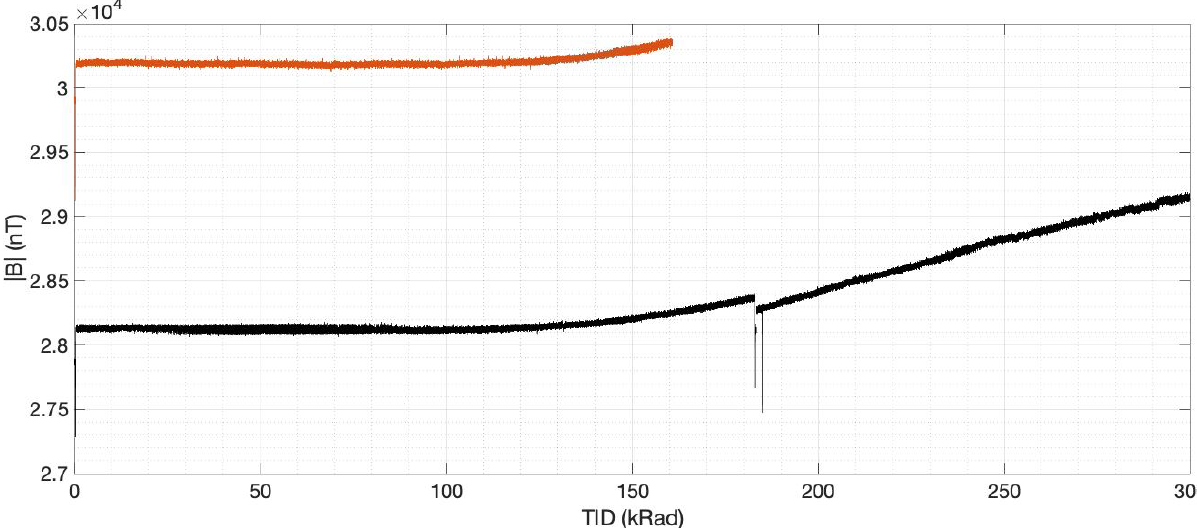
Figure 8. Magnitude of the magnetic field as measured by sensors 8 (orange) and 9 (black) during the test campaign at the GSFC. Sensor 8 started failing after a TID of 150krad ( SI ) .